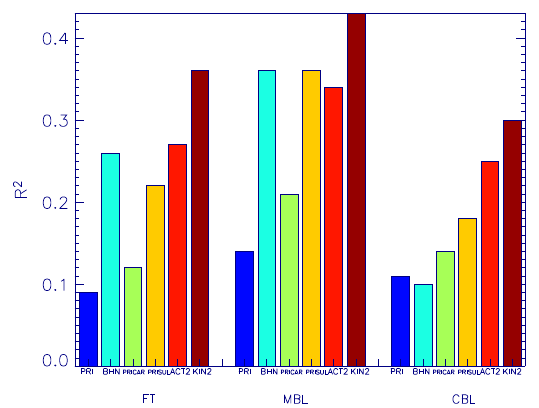
Fig. 7. Correlation coefficients ( R 2 ) between simulated and ob- served monthly mean CN concentrations calculated for the FT, MBL and continental BL (CBL) sites in Table 4. Model runs are described in Table 1.